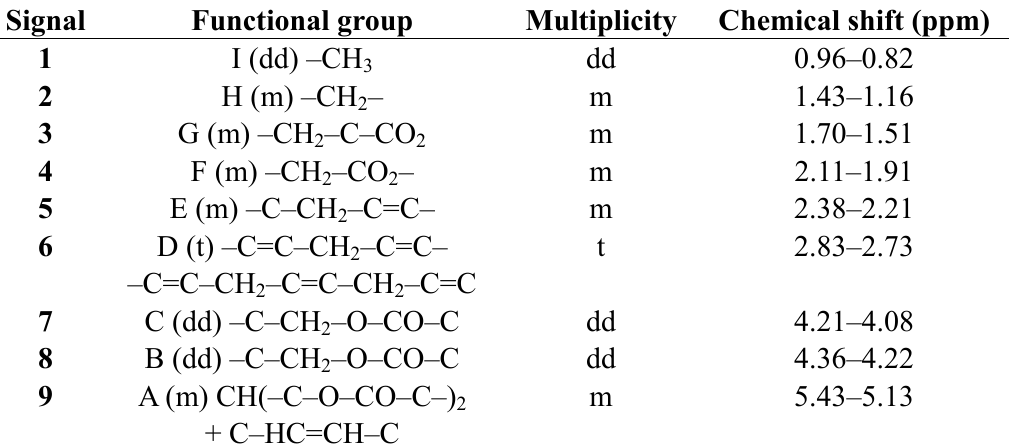
Table 1. Assignment of the signals of Camellia japonica oil 1 H-NMR spectra (300 MHz for 1 H).